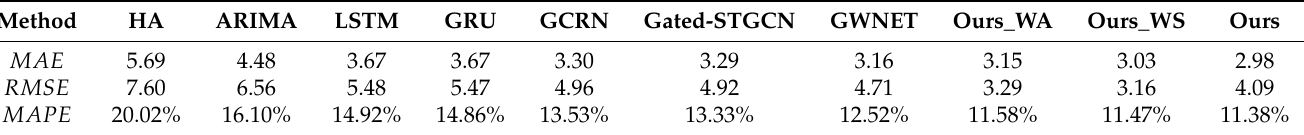
Table 2. The traffic forecasting results under different models with 60 min forecasting interval.